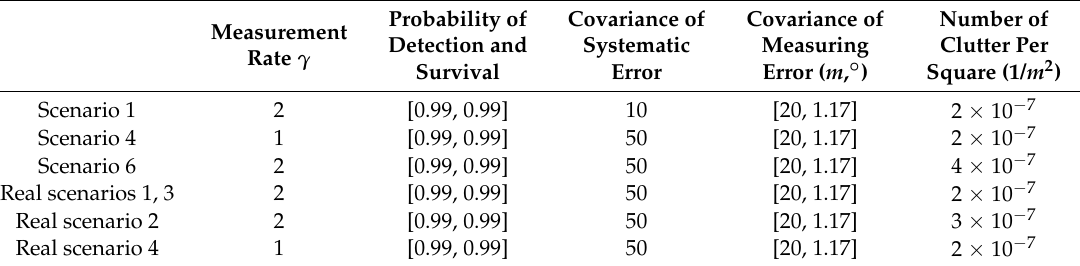
Table A3. Parameter values used in ET-PHD filter.